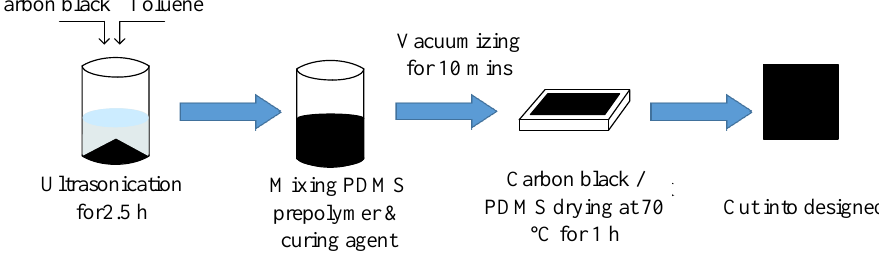
Figure 5. Schematic diagram of dielectric layer preparation.